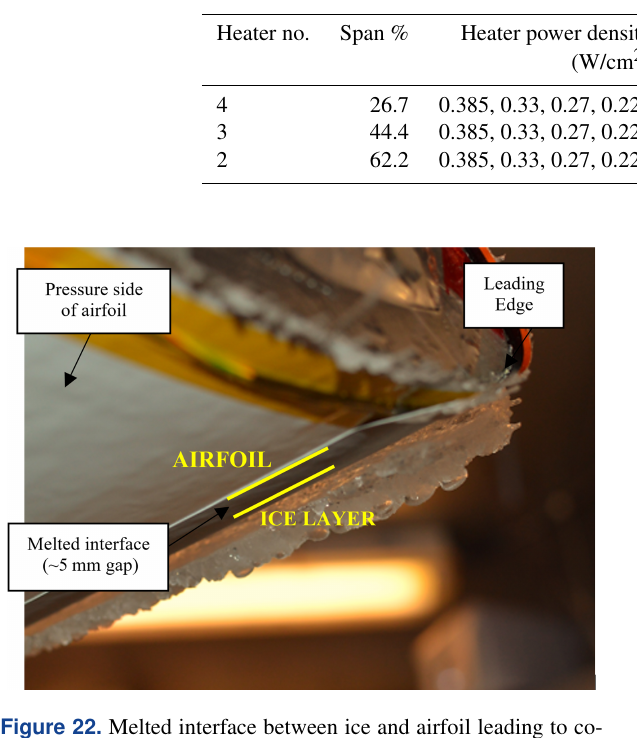
Figure 24. Power density variation shedding times for heater zone